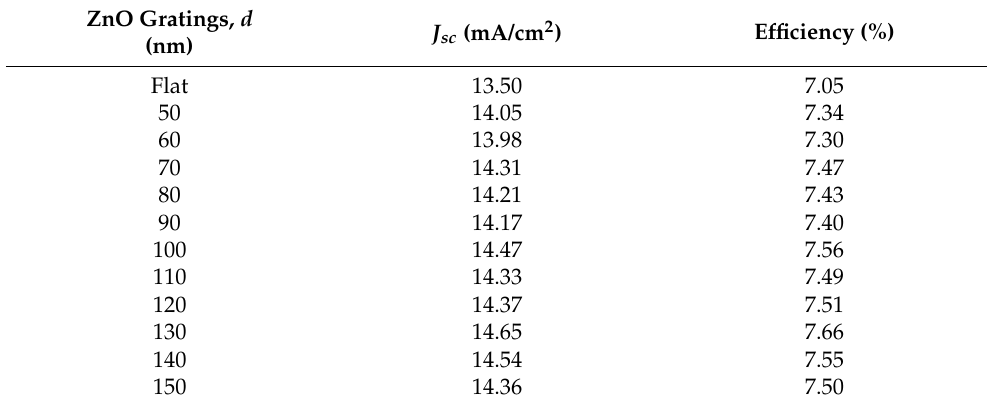
Table 1. Short circuit current density and overall efficiency for different ZnO grating widths.